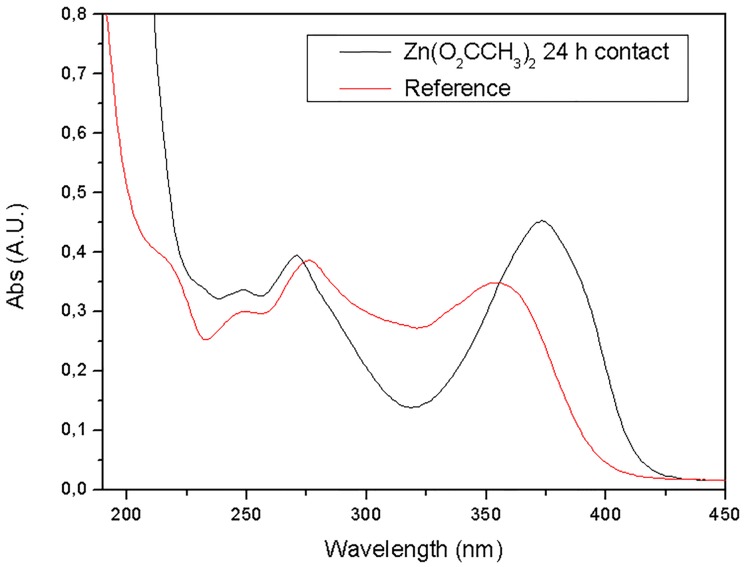
UV-Vis absorption spectra of OTC aliquots of reference and after contact with Zn(CH3COO)2 for 24h.